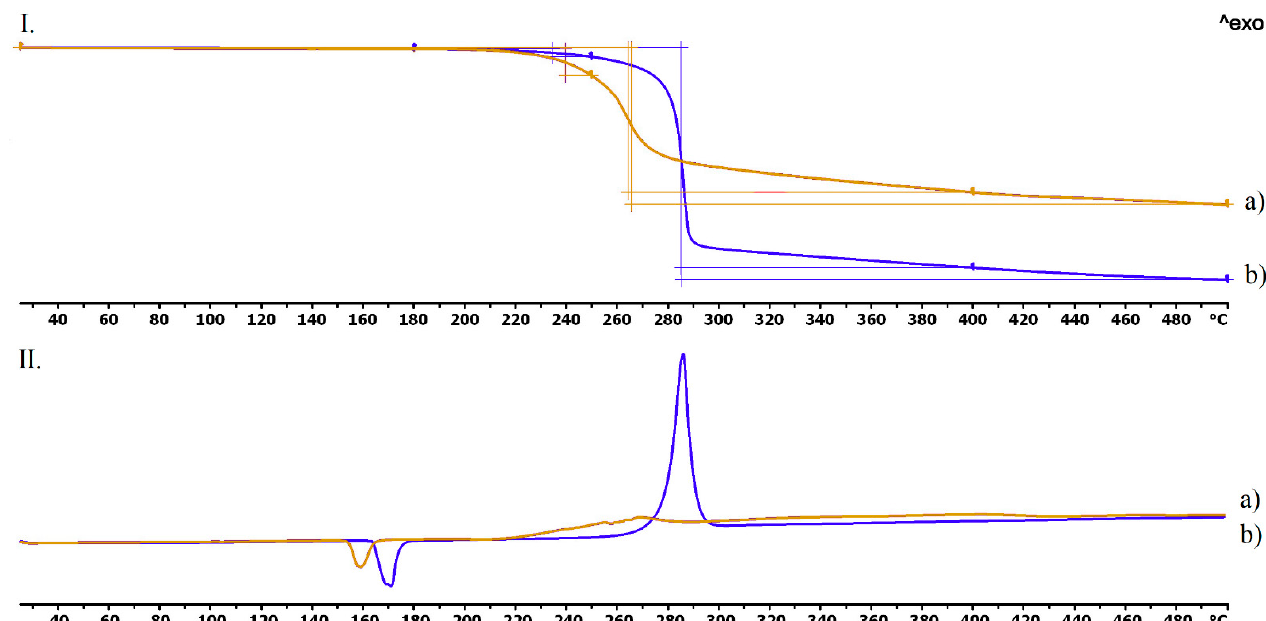
Figure 4. Thermogravimetric ( I ) and heatflow ( II ) analysis of the chloramphenicol ( a ) and the metronidazole ( b ). Thermal behavior was analyzed between 25 °C and 500 °C.